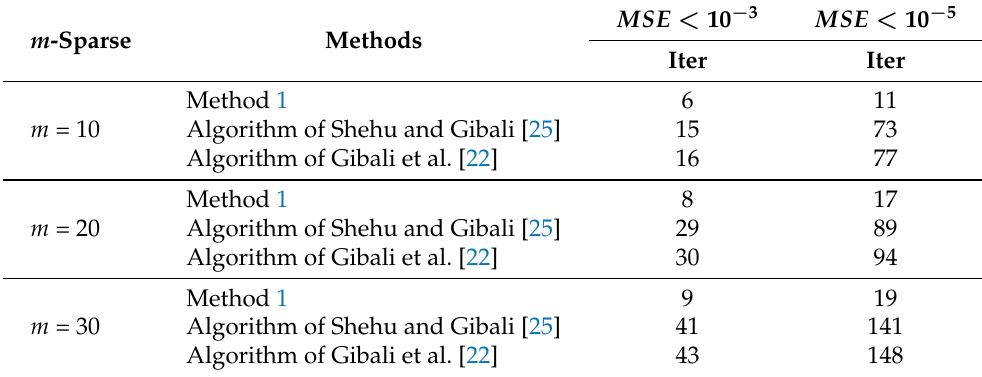
Table 1. Comparison of iteration (Iter) for P = 2048, K = 1024 and different m -sparse, MSE < 10 − 3 and MSE < 10 − 5 .